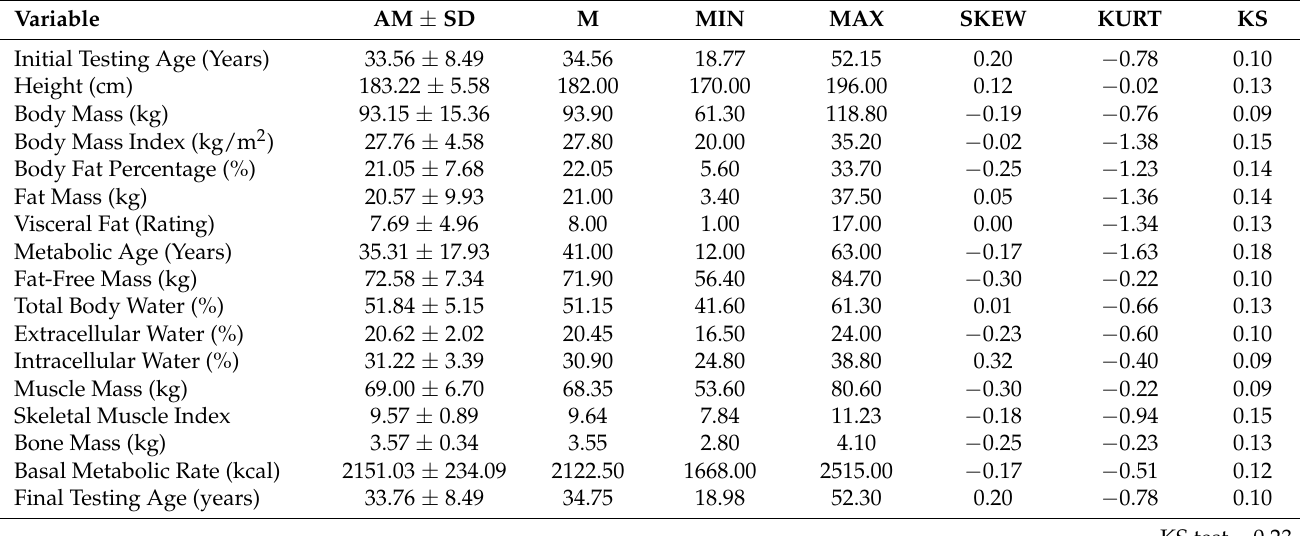
Table 1. Descriptive parameters and sensitivity of the control group (N =